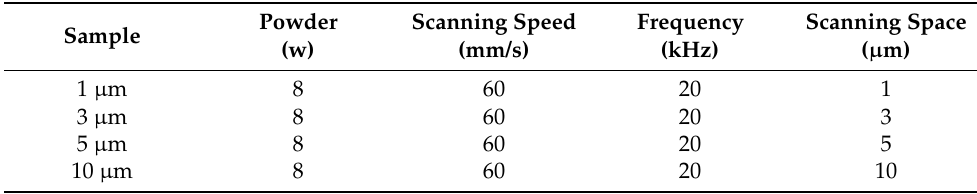
Table 1. Femtosecond laser parameter design.